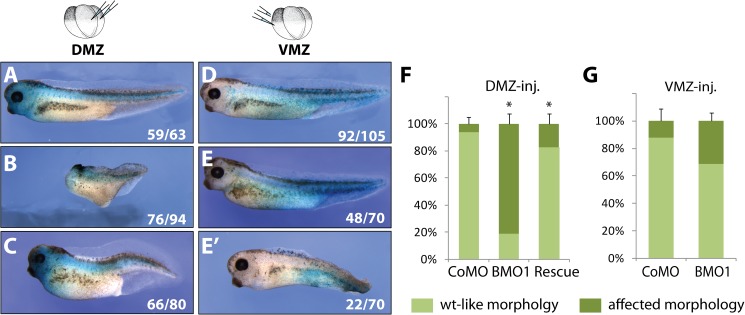
Targeted knockdown of Brg1 protein leads to morphological defects.Dorsal marginal zone (DMZ) injections in X. laevis: (A) CoMO (10ng) injections have no effect on development. (B) BMO1 (10ng) injections cause stunted axes with severely reduced dorso-anterior tissues. (C) Coinjection of BMO1 and hBrg1 mRNA (1ng) restores AP-axes and anterior tissues like eyes, (n = 3 experiments). Ventral marginal zone (VMZ) injections: (D) CoMO (10ng) injection with no phenotype. (E) The majority of BMO1 (10ng) injected embryos appear wildtype-like. (E’) A smaller fraction of BMO1 morphants (10ng) show enlarged heads and eyes paired with deficits in posterior and ventral tissues. All embryos were coinjected with nlacZ mRNA as lineage tracer. (F) and (G) Phenotypic penetrance of DMZ/VMZ injected embryos (n = 3–5 experiments; *, p-value ≤ 0.03).